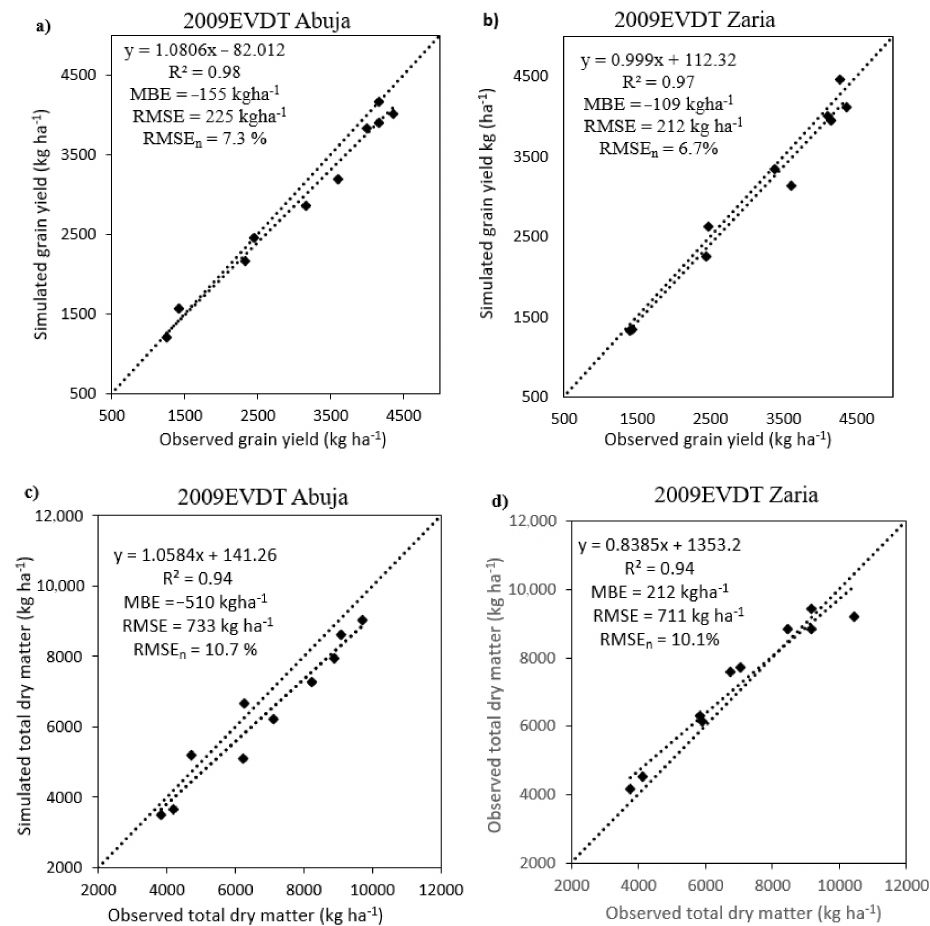
Figure 2. ( a – d ) - Comparison of observed and simulated for grain yield and total dry matter (TDM) at across N–fertilizer applications in two growing seasons (2016 and 2017) at Abuja and Zaria for 2009EVDT maize